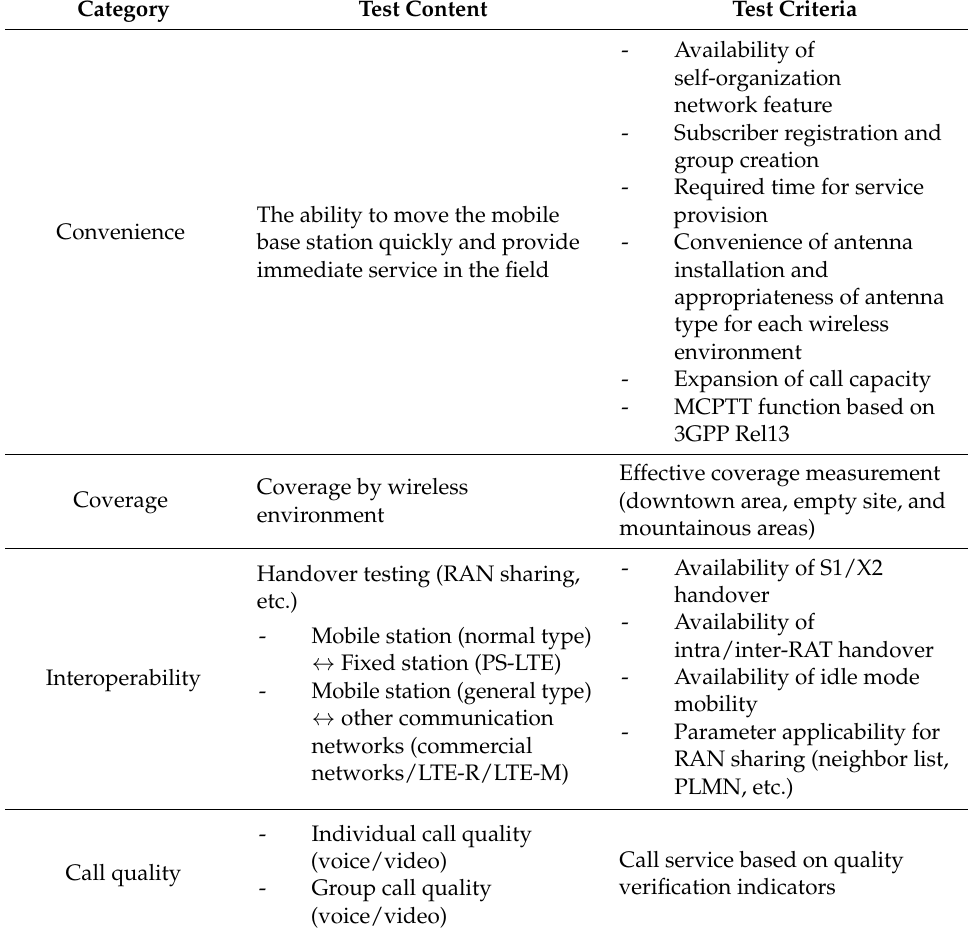
Table 7. Mobile base station test